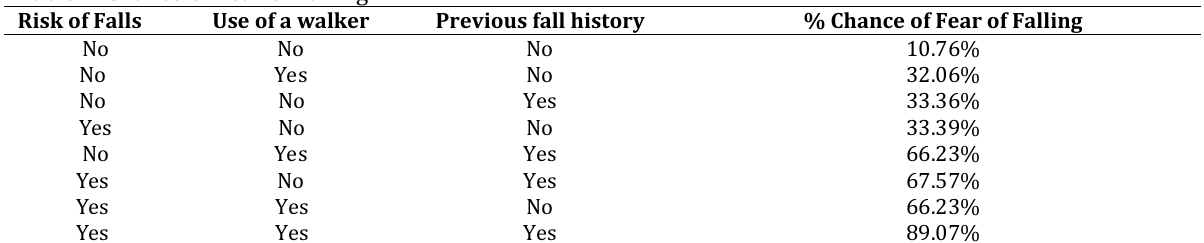
Table 4. Chance of Fear of